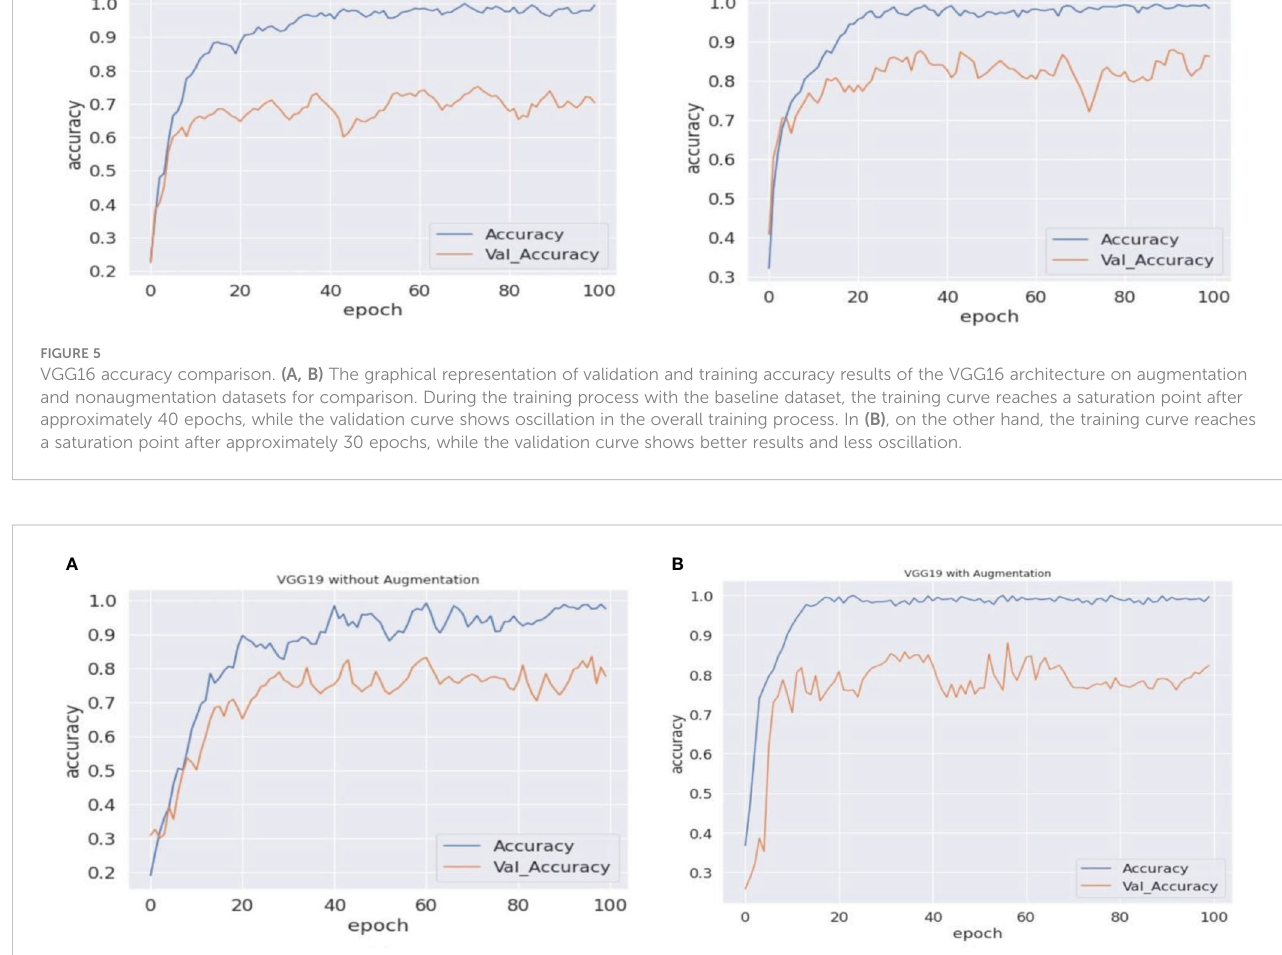
FIGURE 6 VGG19 accuracy comparisons. (A, B) The graphical representation of validation and training accuracy results of the VGG19 architecture on augmentation and nonaugmentation datasets for comparison. During the training process with the baseline dataset, the training curve reaches a saturation point after approximately 85 epochs, while the validation curve shows oscillation in the overall training process. In (B) , on the other hand, the training curve reaches a saturation point after approximately 80 epochs, while the validation curve regularly shows